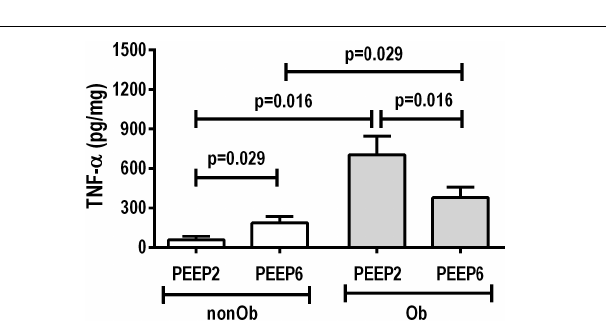
FIGURE 4 | Protein levels of tumor necrosis factor (TNF)- α in lung tissue homogenate in non-obese (nonOb) and obese (Ob) mechanically ventilated groups: Low-PEEP (2 cmH 2 O) and High-PEEP (6 cmH 2 O). Bars represent means +SD of seven animals in each